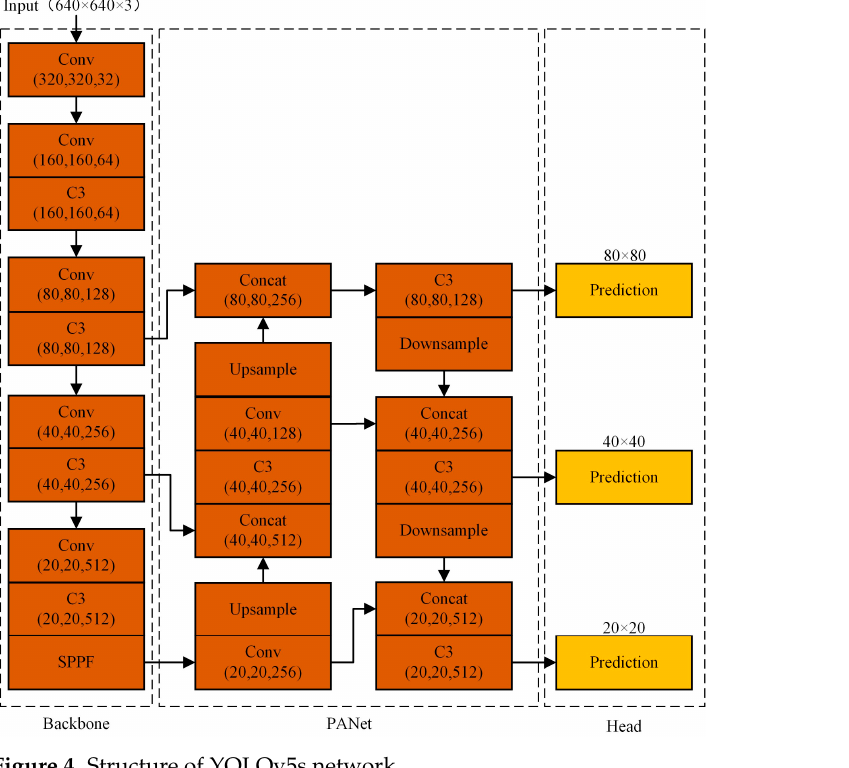
Figure 4. Structure of YOLOv5s network.